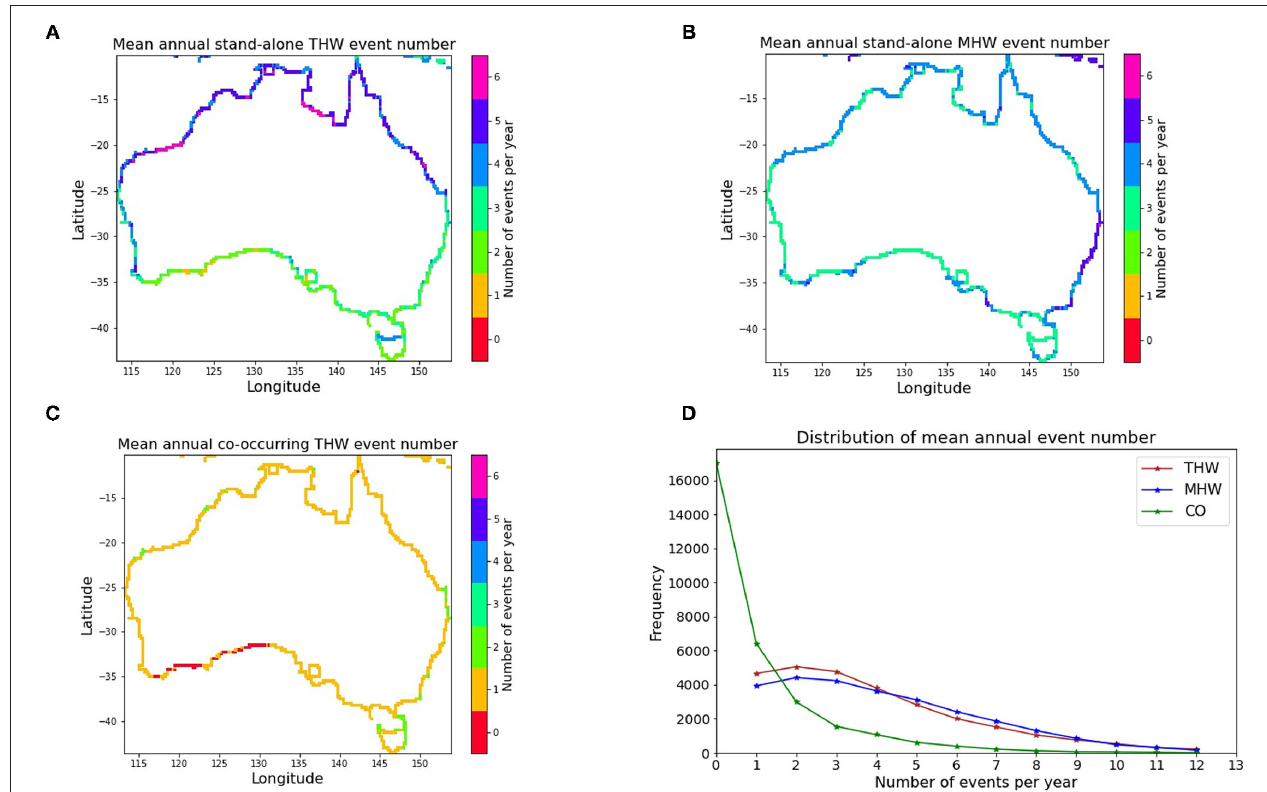
FIGURE 2 | Annual heatwave events averaged for each coastal grid cell for (A) stand-alone THWs, (B) stand-alone MHWs and (C) co-occurring THWs. (D) Frequency distribution of annual mean terrestrial, marine and co-occurring heatwave numbers for all [828] 0.5 ◦ grid cells around the coastal belt of Australia from 1982 to 2018.